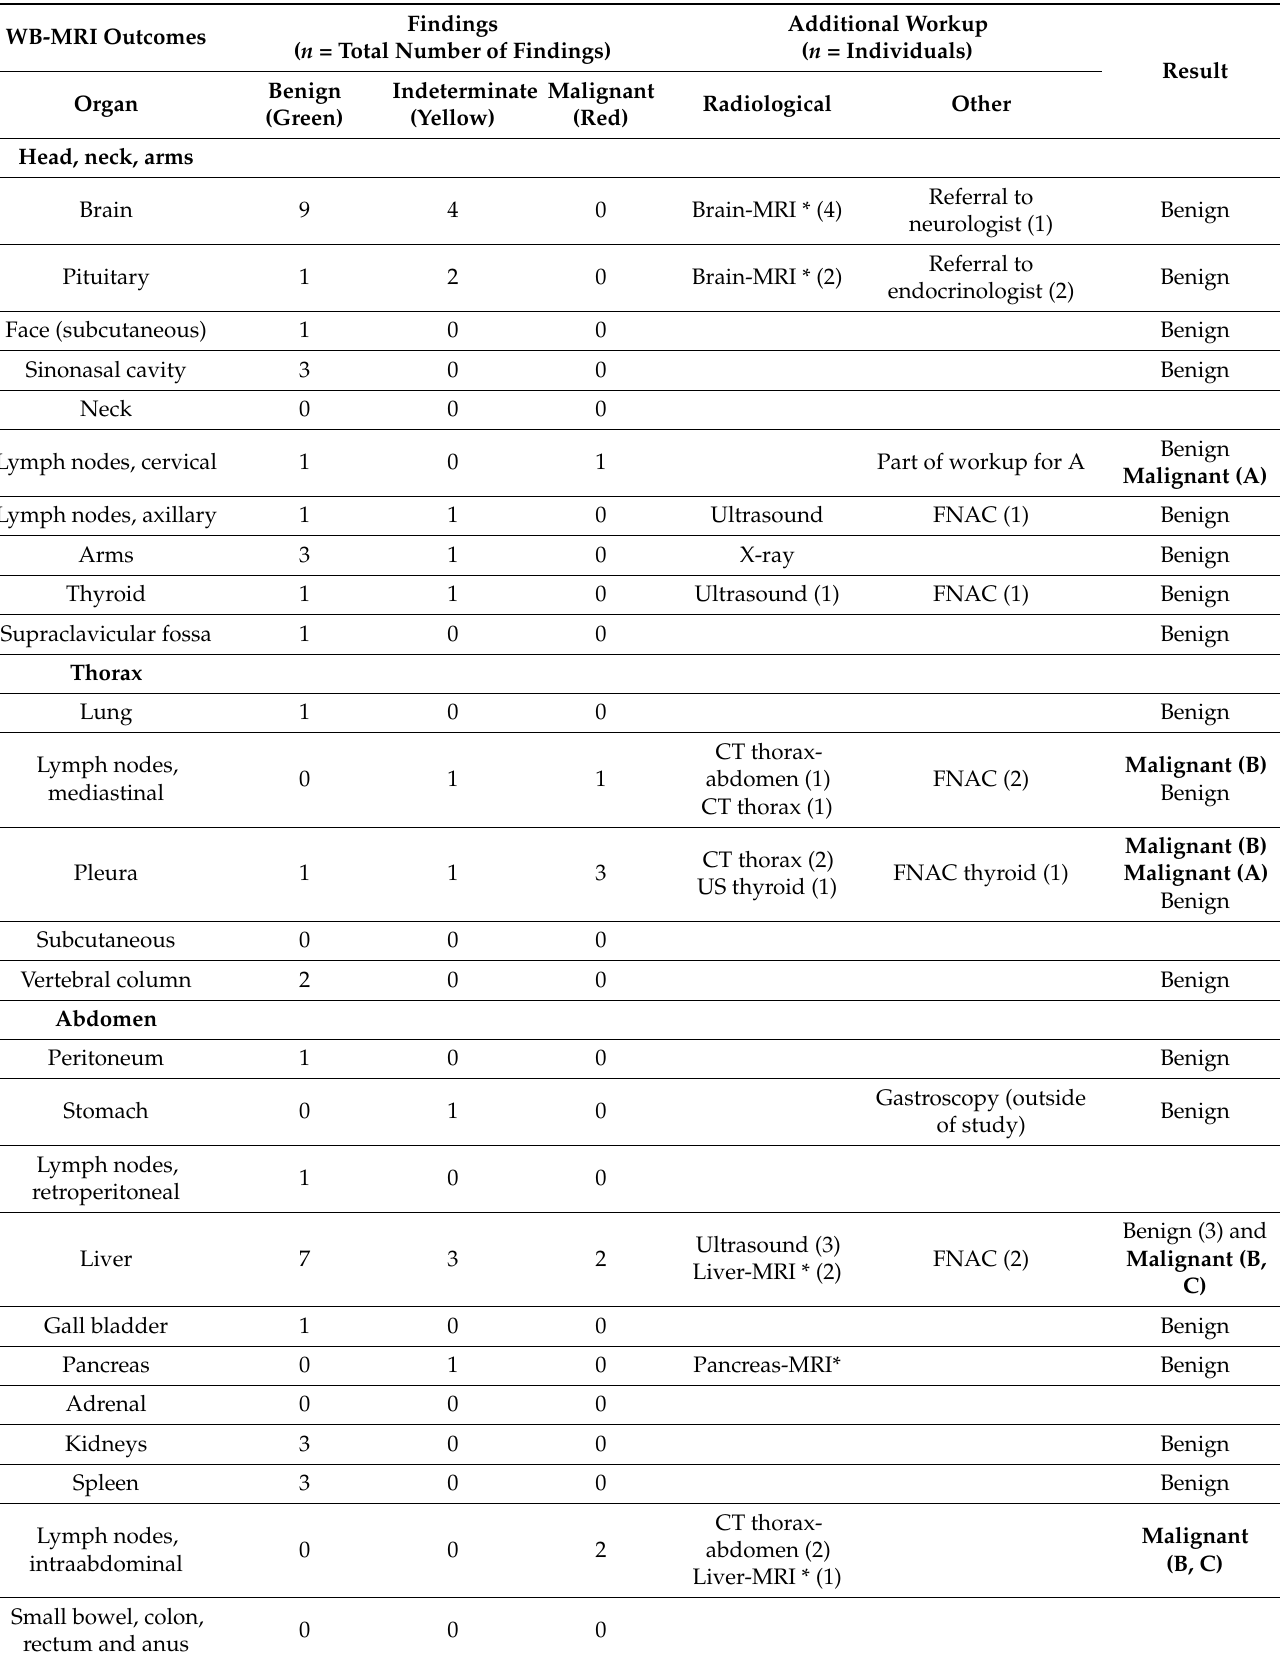
Table 2. WB-MRI outcomes in the 61